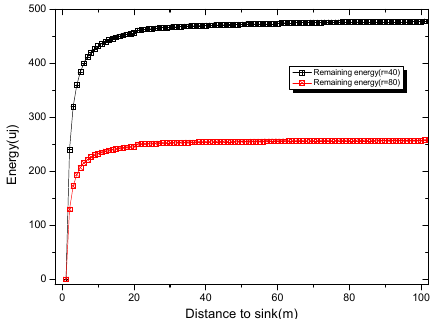
Figure 10. The remaining energy of the node can support increasing the active slot and increasing the radius.